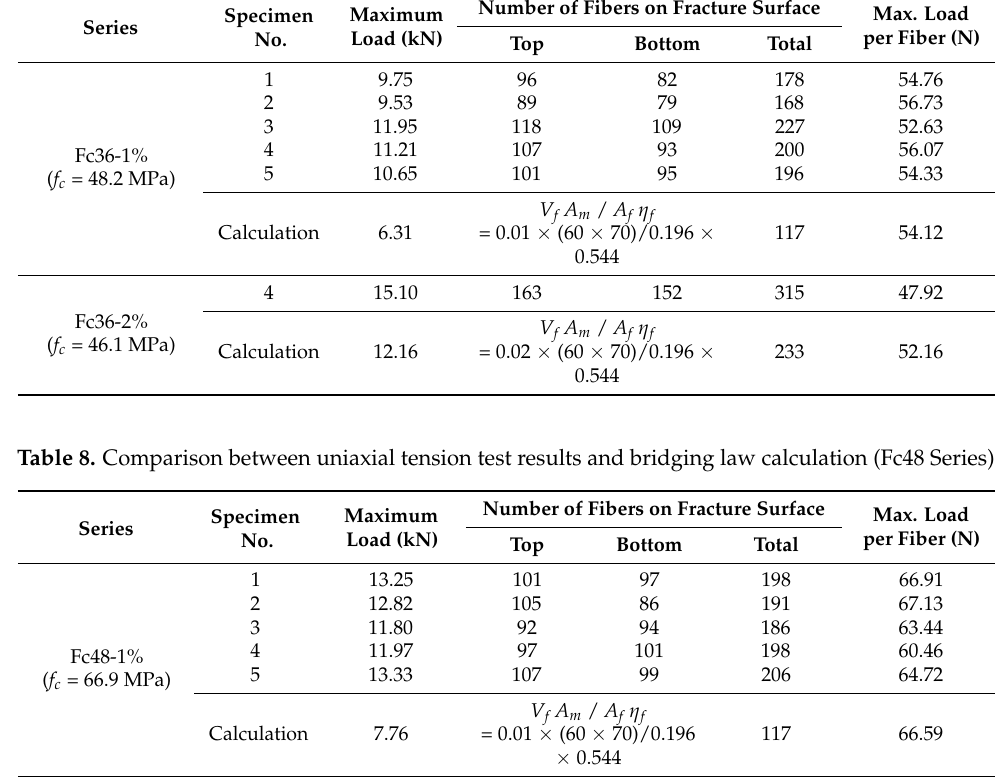
Table 7. Comparison between uniaxial tension test results and bridging law calculation (Fc36 Series). Series